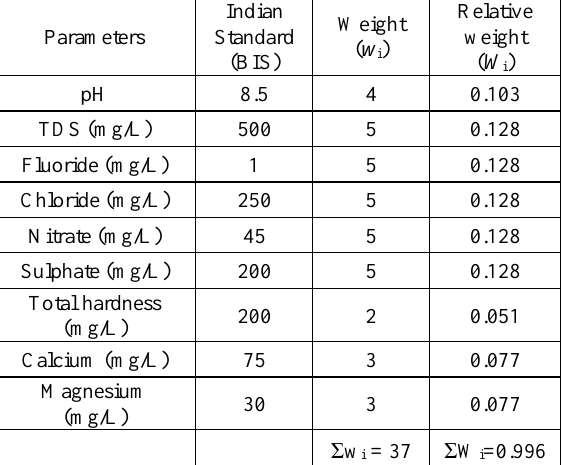
Table 5. Relative weight of chemical